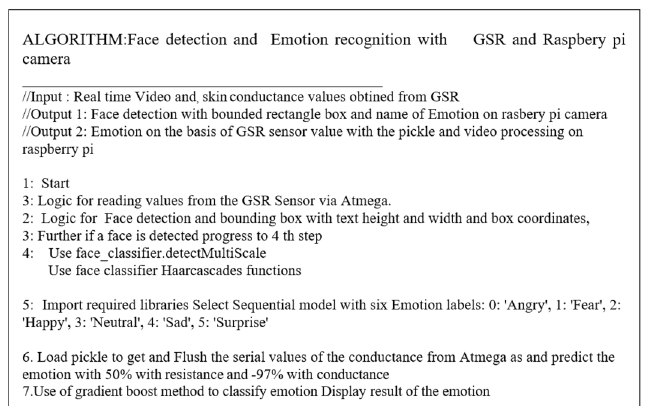
Fig. 7 Algorithmic steps for proposed emotion detection with GSR and visual FER method